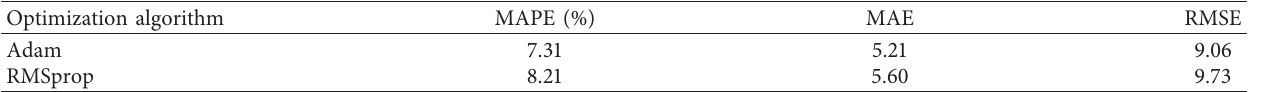
Table 3: Comparison of three evaluation indicators between RMSProp and Adam. Optimization algorithm MAPE